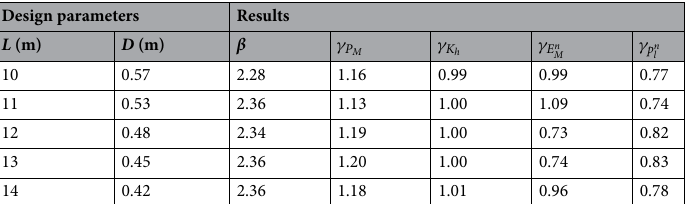
is the partial factor of the pile- h